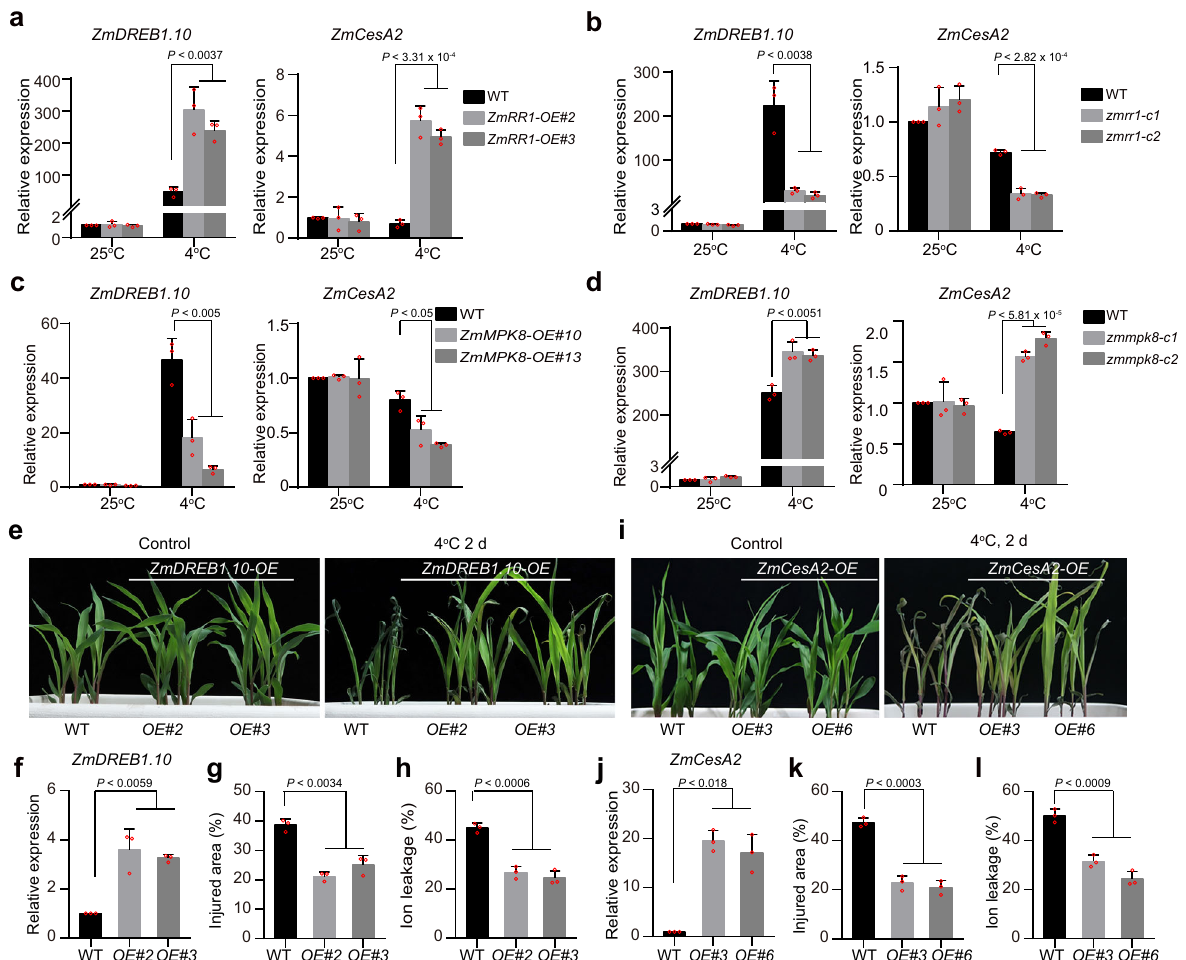
Fig. 6 ZmRR1 regulates chilling tolerance by modulating the expression of ZmDREB1 and ZmCesA genes. a – d Relative expression levels of ZmDREB1.10 and ZmCesA2 in 10-day-old wild type, ZmRR1-OE ( a ) zmrr1 mutant ( b ), ZmMPK8-OE ( c ), and zmmpk8 plants ( d ) under cold treatment at 4 °C for 12 h. e – h Chilling phenotypes ( e ), ZmDREB1.10 expression ( f ), injured area ( g ), and ion leakage ( h ) of ZmDREB1.10 overexpression transgenic plants. i – l Chilling phenotypes ( i ), ZmCesA2 expression ( j ), injured area ( k ), and ion leakage ( l ) of ZmCesA2 overexpression transgenic plants. In f and j , ZmDREB1.10 and ZmCesA2 expression were examined in 25 °C-grown seedlings. In a , b , c , d , f , j , data are the mean values± SD ( n = 3; two-sided t -test). Three independent experiments were performed with similar results. In g , h , k , l , each bar represents the mean ± SD of three independent experiments. The statistical signi fi cance was determined by a two-sided t -test. Source data underlying Fig. 6a – d, f – h, and j-l are provided as a Source Data fi phenotypes and ZmDREB1 gene expression. Overexpression of cold stress, ZmRR1 accumulates and induces the expression of ZmDREB1s and ZmCesAs , thus enhancing chilling tolerance. ZmRR1 is phosphorylated by cold-activated ZmMPK8 at Ser15, which promotes the ubiquitin-mediated degradation of ZmRR1. The stability of ZmRR1 protein is improved in an allele of ZmRR1 HapA from natural maize varieties under cold stress due to the deletion of the ZmMPK8 phosphorylation site, thus providing a new strategy for breeding chilling-tolerant crops.